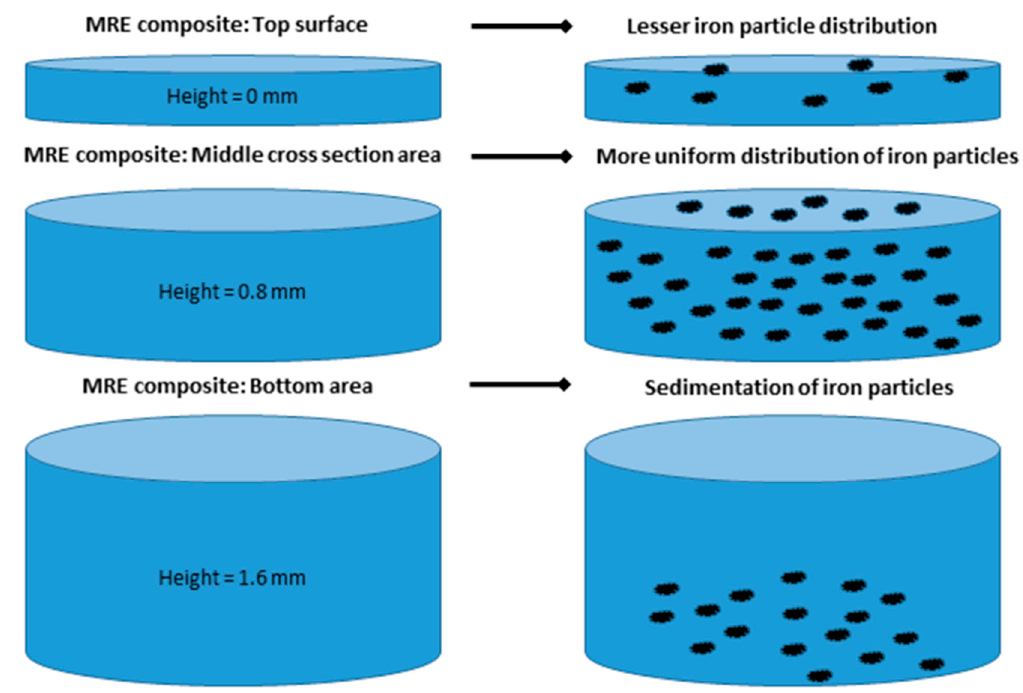
Figure 10. Iron particle distribution within various heights of the MRE composite from the top to the bottom areas. 170